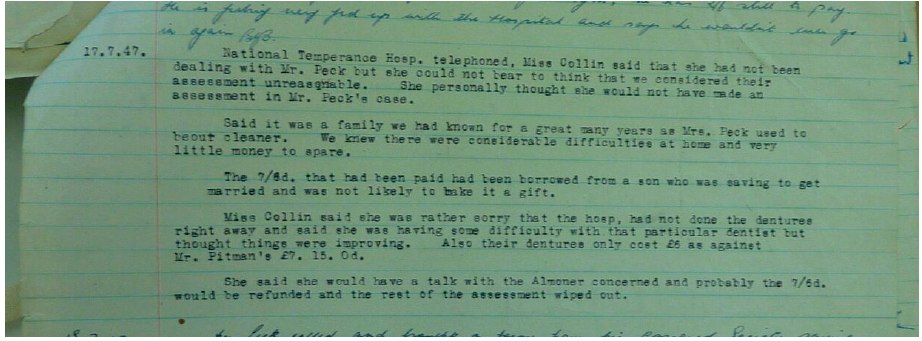
Figure 4. Entry in COS case notes, 17 July 1947.